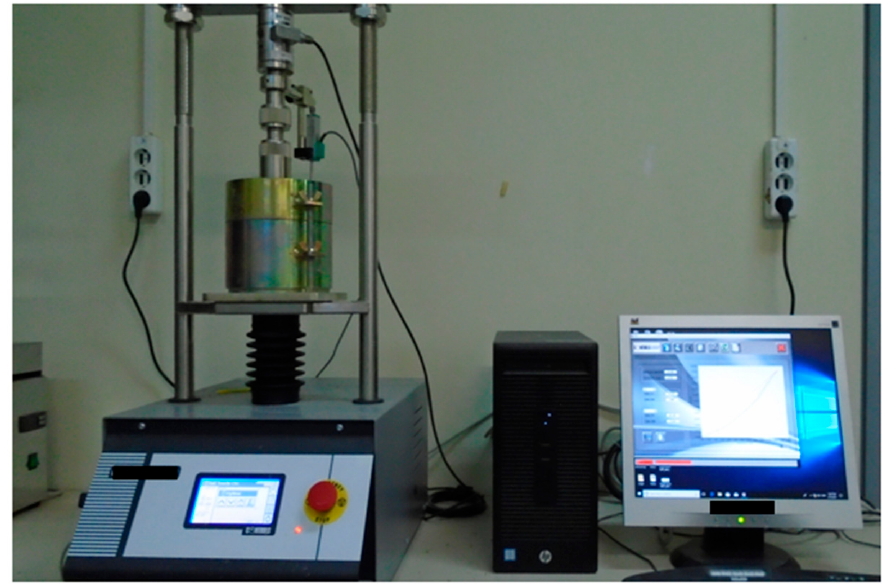
Figure 2. Equipment for CBR